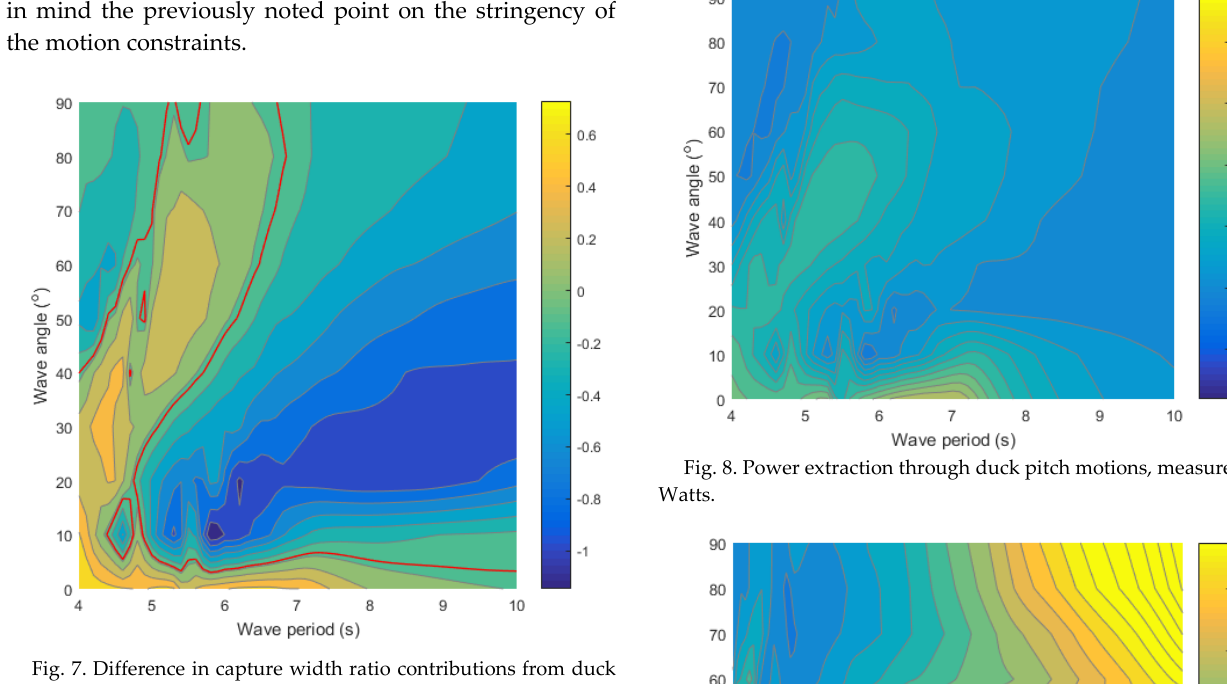
Fig. 7. Difference in capture width ratio contributions from duck pitching and joint flexing. In yellow regions, more power is extracted through pitching of the ducks than by the flexing of the joints. The red line shows the boundary along which capture width contribution of duck pitching and joint flexing is equal.